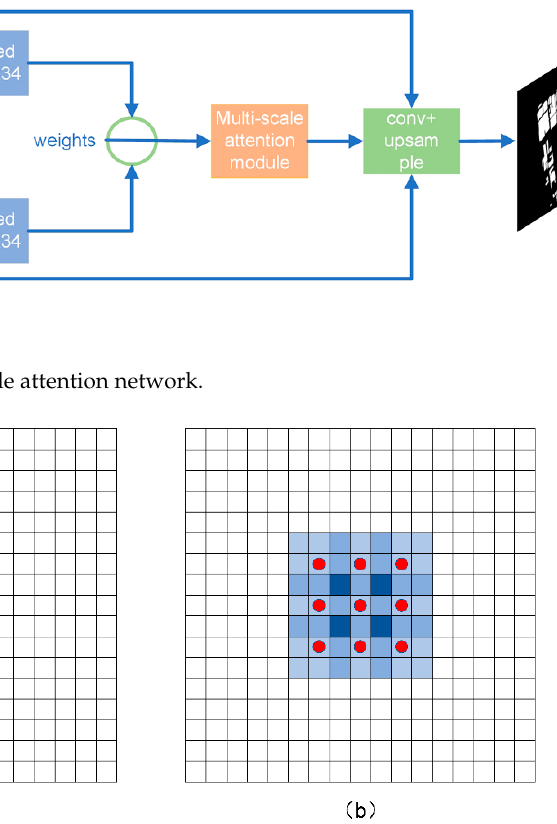
Figure 5. The contrast between dilated convolution and traditional convolution. ( a ) normal convolution, ( b ) 3 × 3 null convolution with an expansion rate of 2.